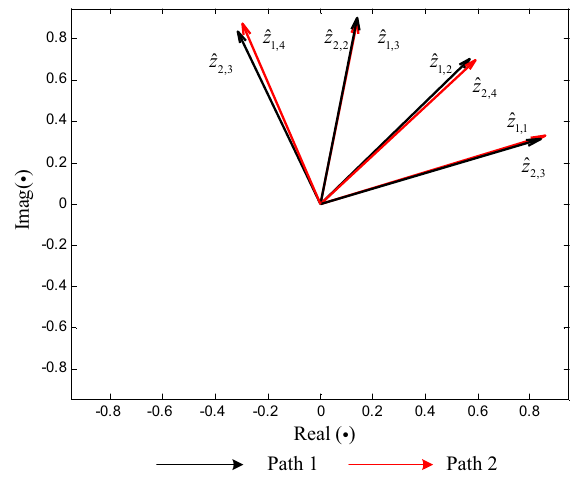
Figure 5. Clustering of corrected vector quantities ˆ z l , m